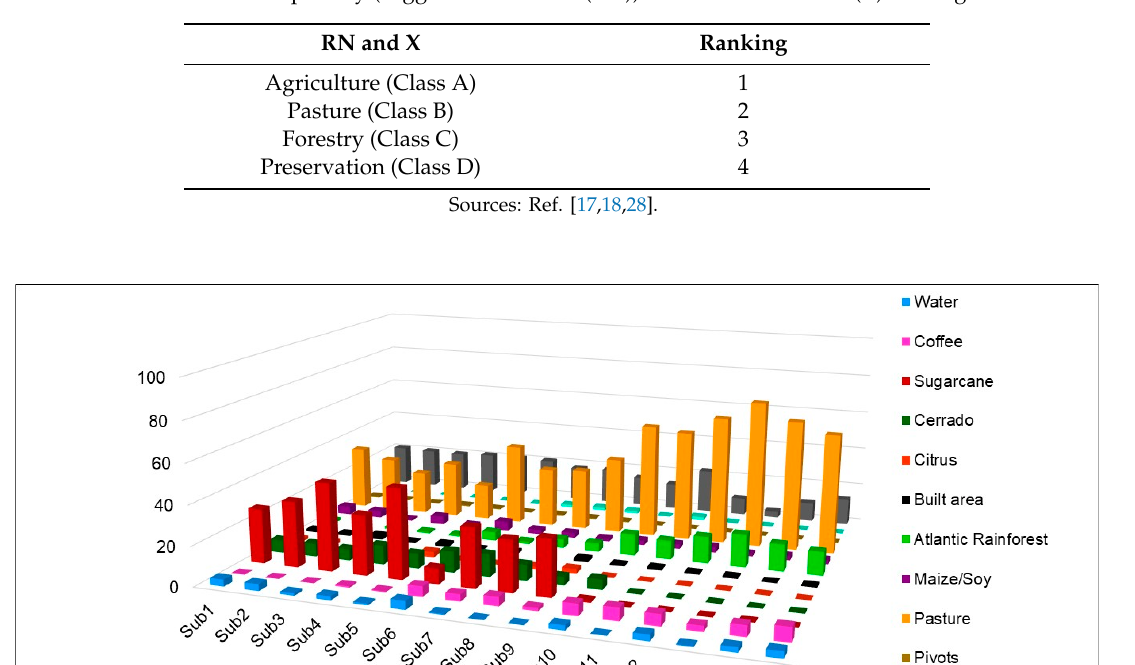
Table 1. Soil capability (ruggedness number (RN)) and actual land uses (X) ranking.